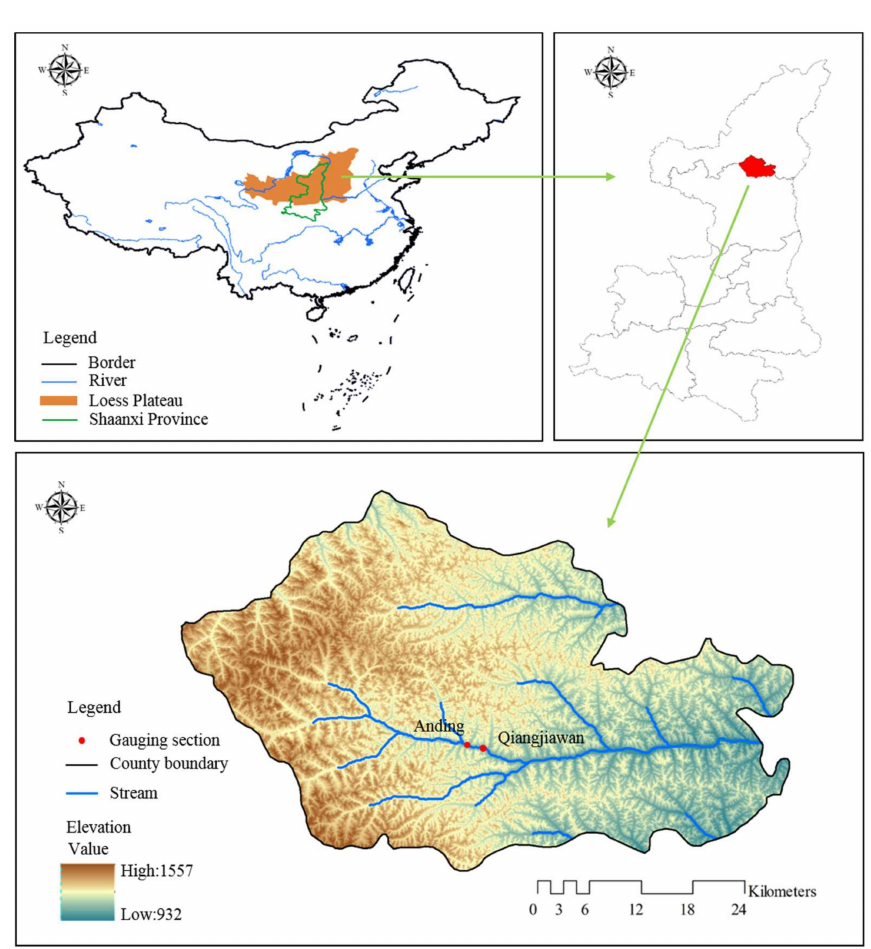
Figure 1. Location of Zichang County and the distribution of disaster prevention